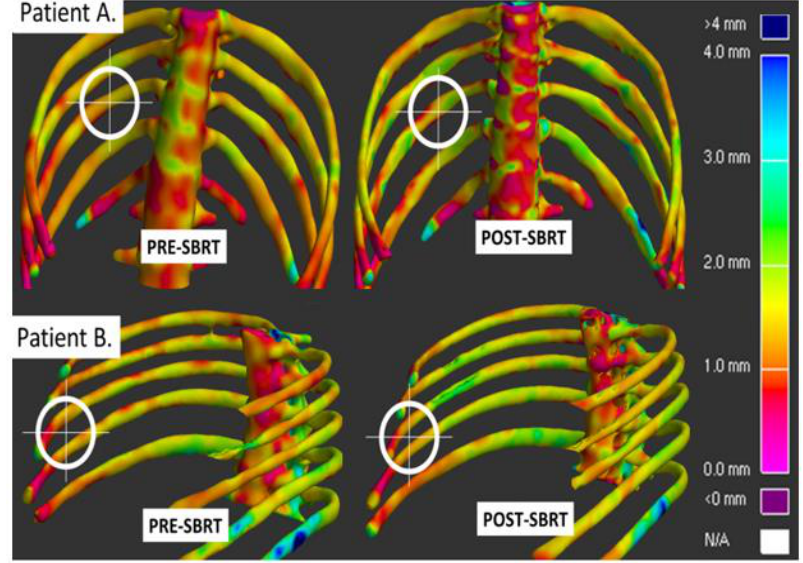
Figure 4. Minimal cortical thinning was observed in the ribs of two lung cancer patients who were taking risedronate for osteoporosis at the time of SBRT. The tumors were located near the rib wall. The rib regions of interest are within the white “target” which is adjacent to the tumor and received > 30 Gy. The lack of thinning is noted by no marked increase in red coloration of bone in the post SBRT scans.